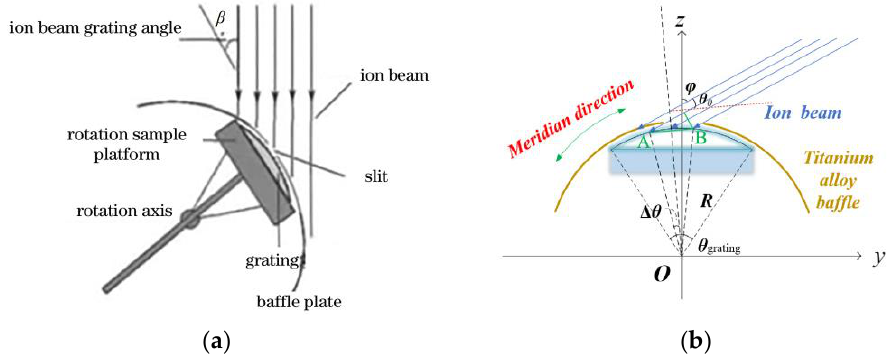
Figure 6. Schematic diagram of ion beam etching for making convex blazed grating. ( a ) Ion beam etching scanning stage [48]. ( b ) Oscillating ion beam etching model